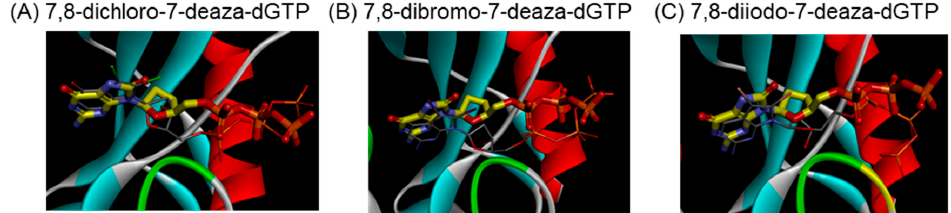
Figure 3. Images of optimal docking conformations of ( A ) 7,8-dichloro-7-deaza-dGTP ( 7 ) (thin stick with nitrogen colored in blue, oxygen colored in red, phosphorus colored in orange and chlorine colored in green), ( B ) 7,8-dibromo-7-deaza-dGTP ( 10 ) (thin stick with bromine colored in reddish brown), and ( C ) 7,8-diiodo-7-deazadGTP ( 13 ) (thin stick with iodine colored in light purple) in the binding pocket of MTH1 relative to 8-oxo-dGTP (thick stick with carbon colored in yellow).